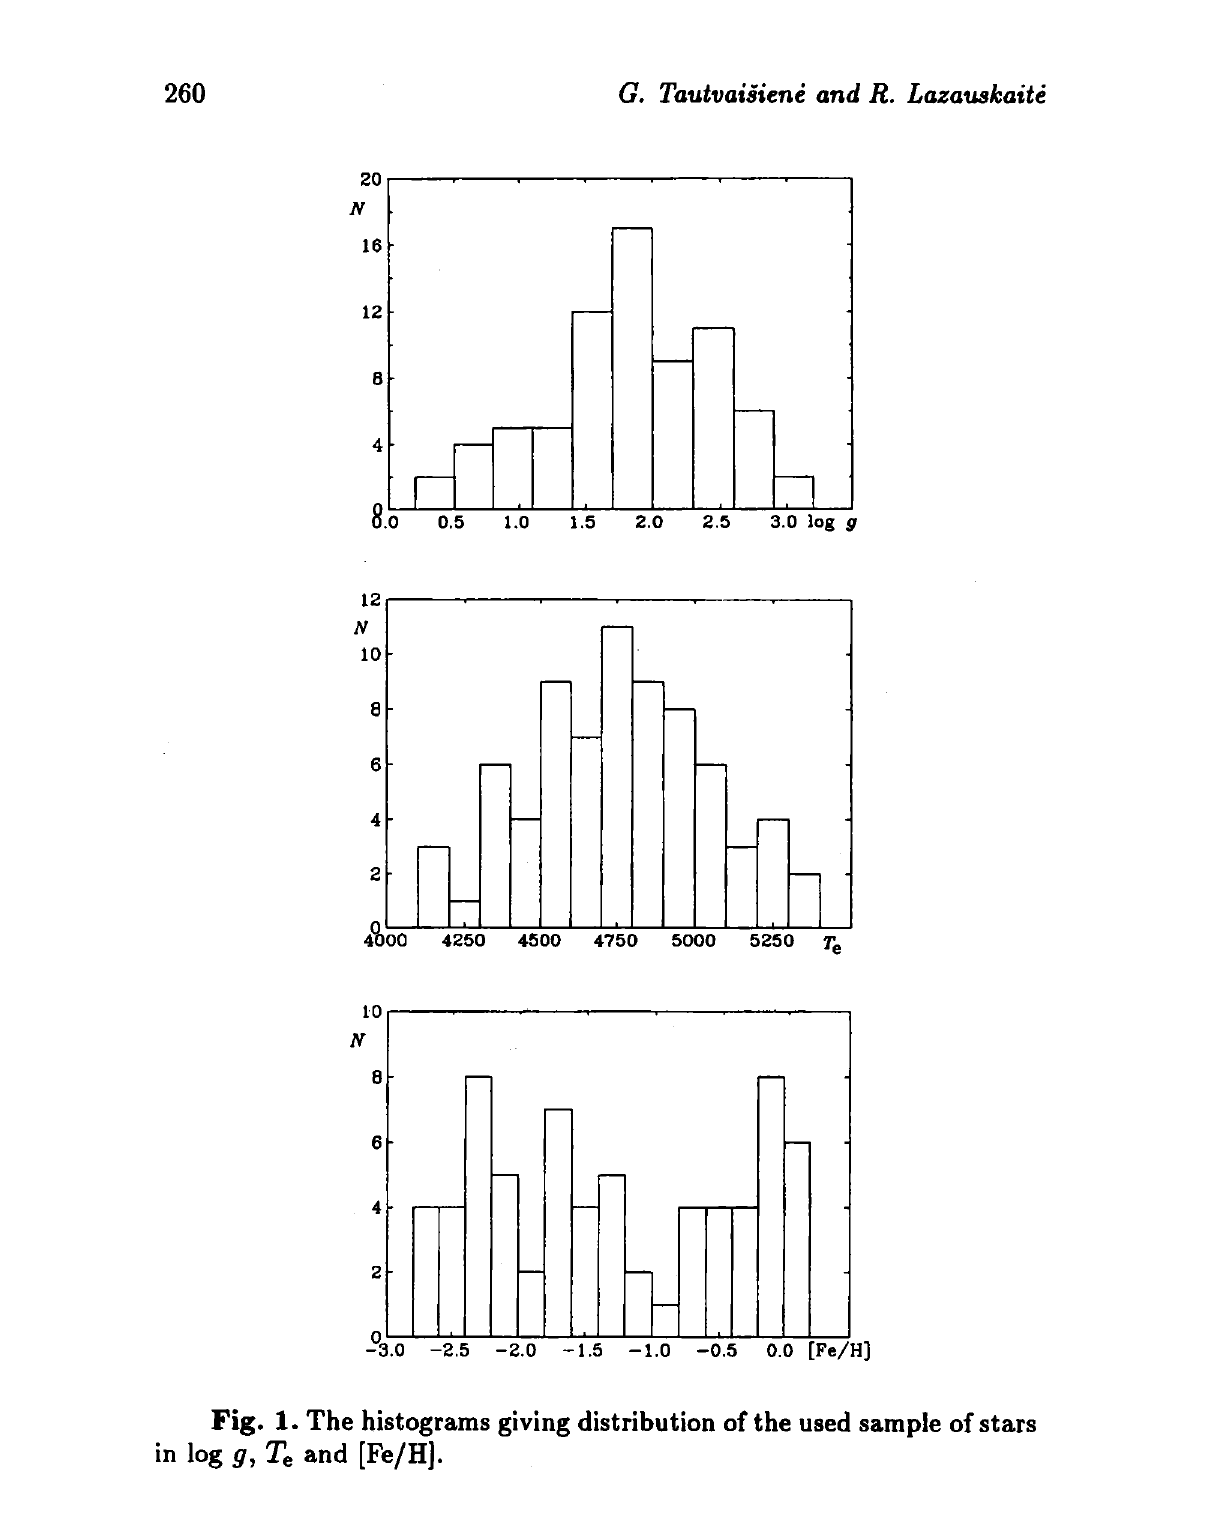
Fig. 1. The histograms giving distribution of the used sample of stars in log g, T e and